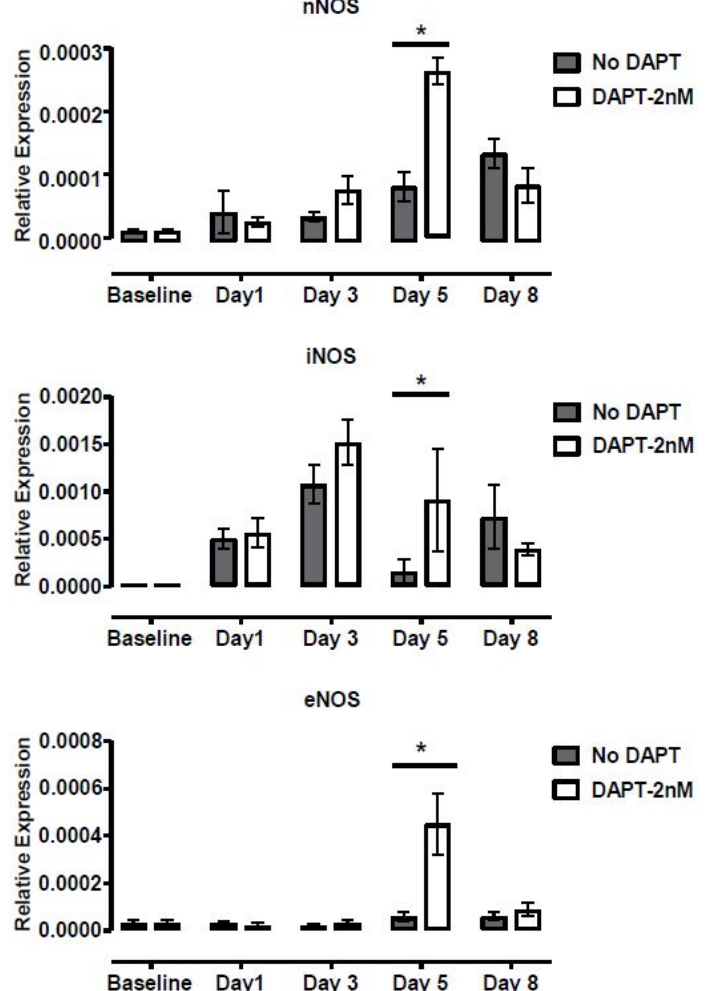
Figure 7. Effect of 2 nM of DAPT on Nos expression. Treatment of MTCs in suspension with 2 nM of DAPT led to significant increase in iNos , eNos , and nNos gene expression as compared to586 untreated, control samples on Day 5. All data was normalized to mouse β -actin. * represents two-tailed p < 0.001.